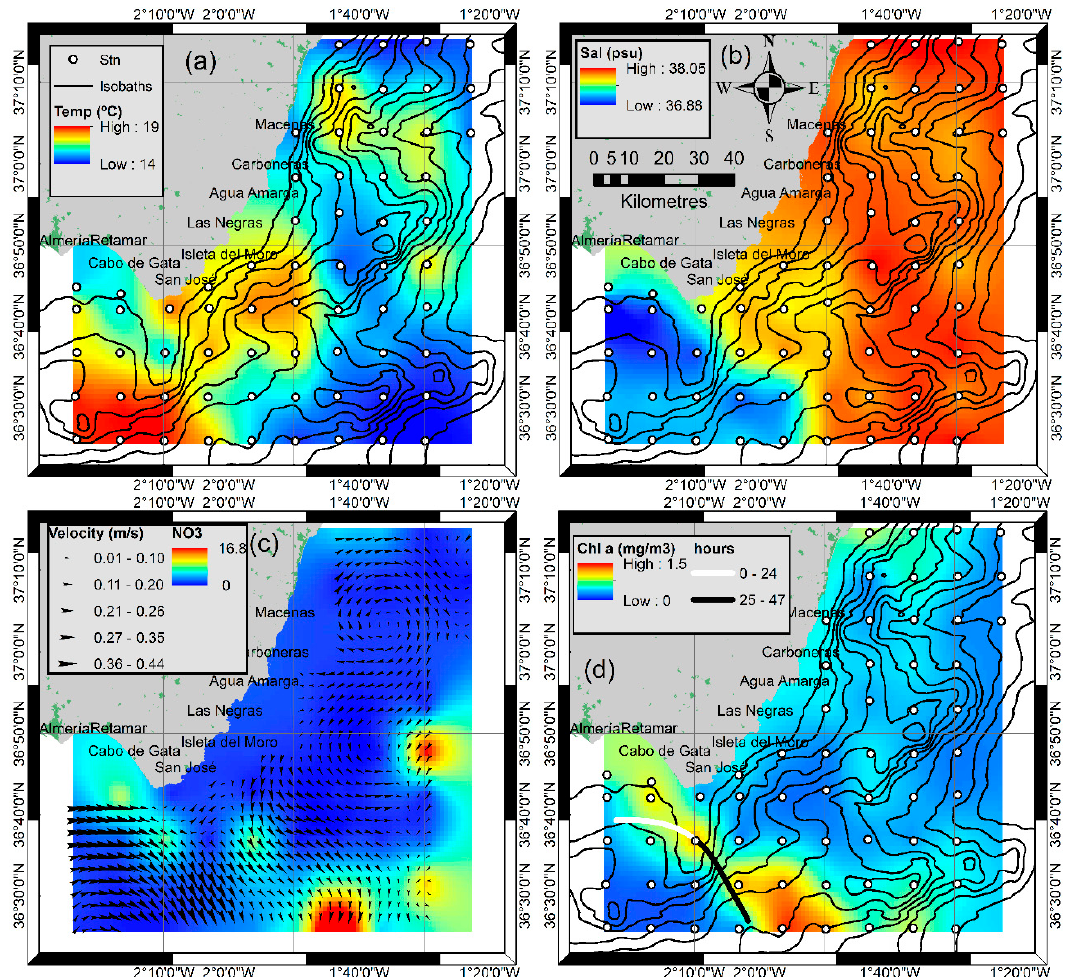
Figure 3. Spatial patterns at 50-m depth of ( a ) temperature ( ◦ C), ( b ) salinity, ( c ) nitrate concentration ( µ M) and horizontal currents (m · s − 1 ), and ( d ) chlorophyll a concentration (mg · m − 3 ) and horizontal particle track from longitude 2.367 W and latitude 36.655 N (between Stn 12 and Stn 13) at 50-m depth. Note that scales in Figures 2 and 3 are different; temperature decreases, salinity increases, and notably, chlorophyll a concentration increases one order of magnitude.